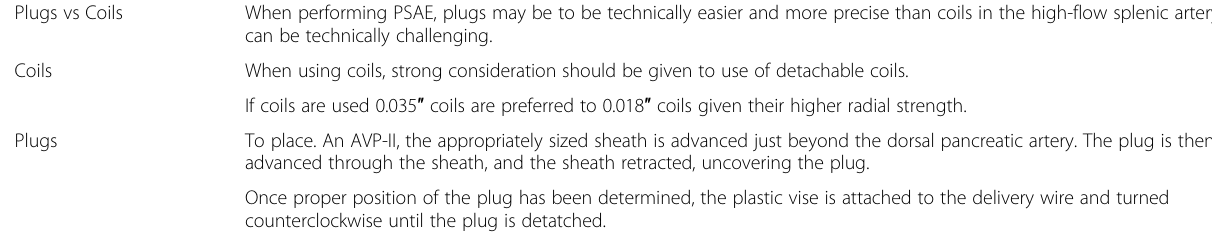
Table 4 Pearls and Pitfalls of Splenic Artery Embolization Plugs vs Coils